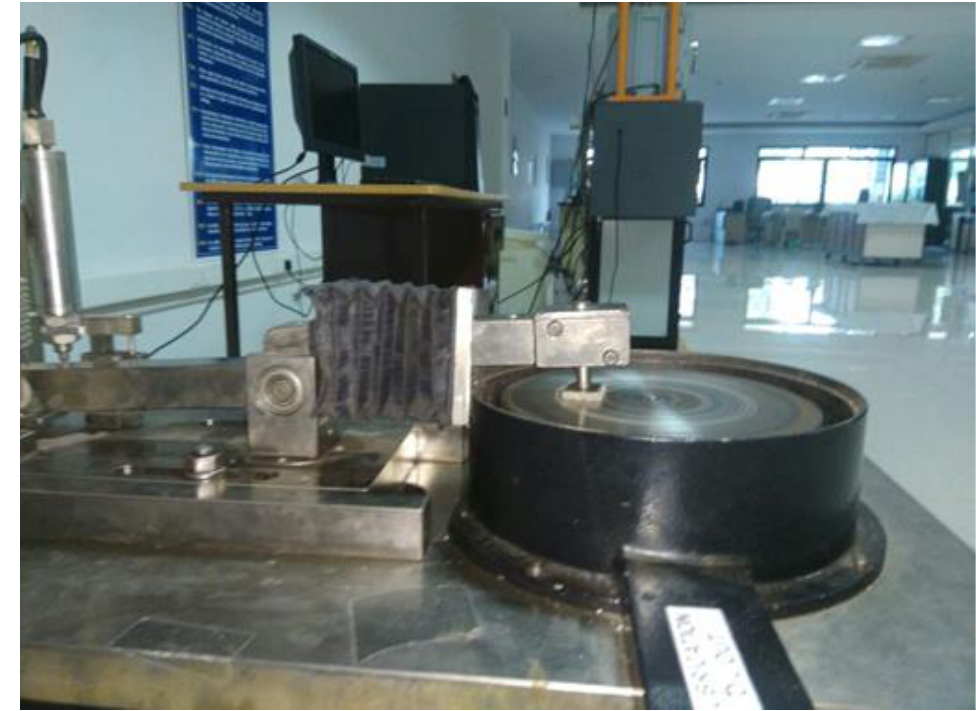
Figure 2. Experimental setup for pin-on-disc wear tester. The two wear parameters measured were, in particular, wear rate (WR), obtained by the ratio of volume loss (VL) in m 3 divided by sliding distance (SD) in m, and coefficient of friction (COF), obtained by the resistive force of friction (Fr) divided by the normal force (F) that pushes the two forces together.